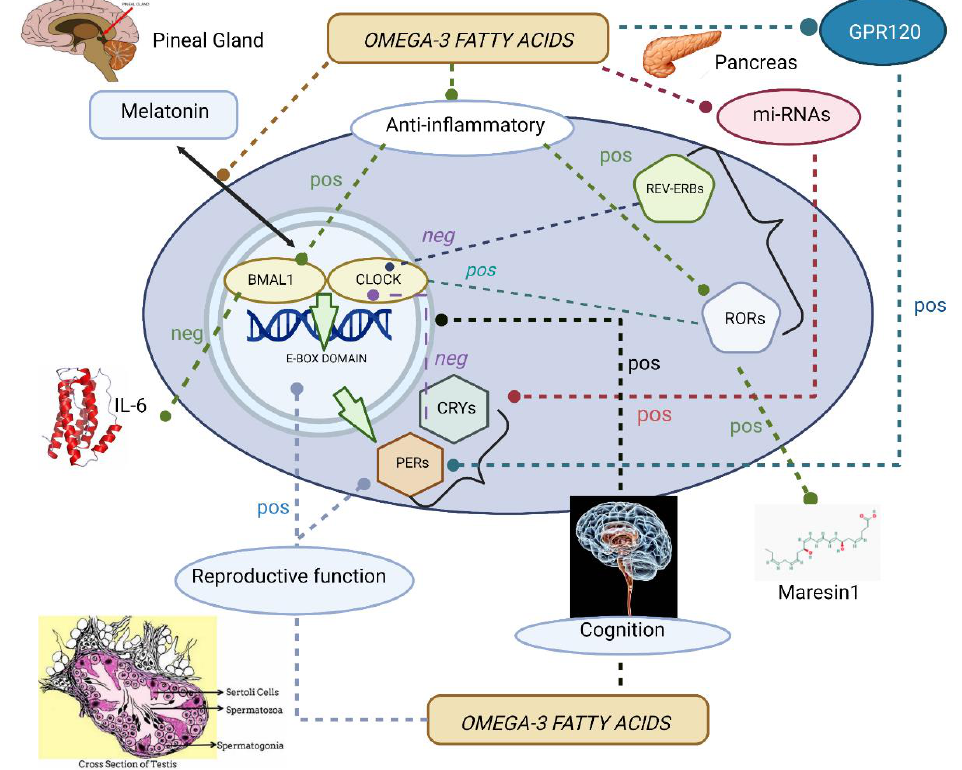
Figure 1. Schematic representation of the molecular machinery of the biological clock and modulation by omega-3 fatty acids to regulate the diversity of physiological functions. Abbreviations: GPR120 = G-protein coupled receptor 120; miRNAs = microribonucleic acids; pos = positive feedback; neg = negative feedback; IL-6 = interleukin-6; BMAL1 = brain and muscle Arnt-like protein 1; CLOCK = circadian locomotor output cycles kaput; PER = period; CRY = cryptochrome; REV-ERB = reverse erythroblastoma; ROR = retinoid-orphan receptor.